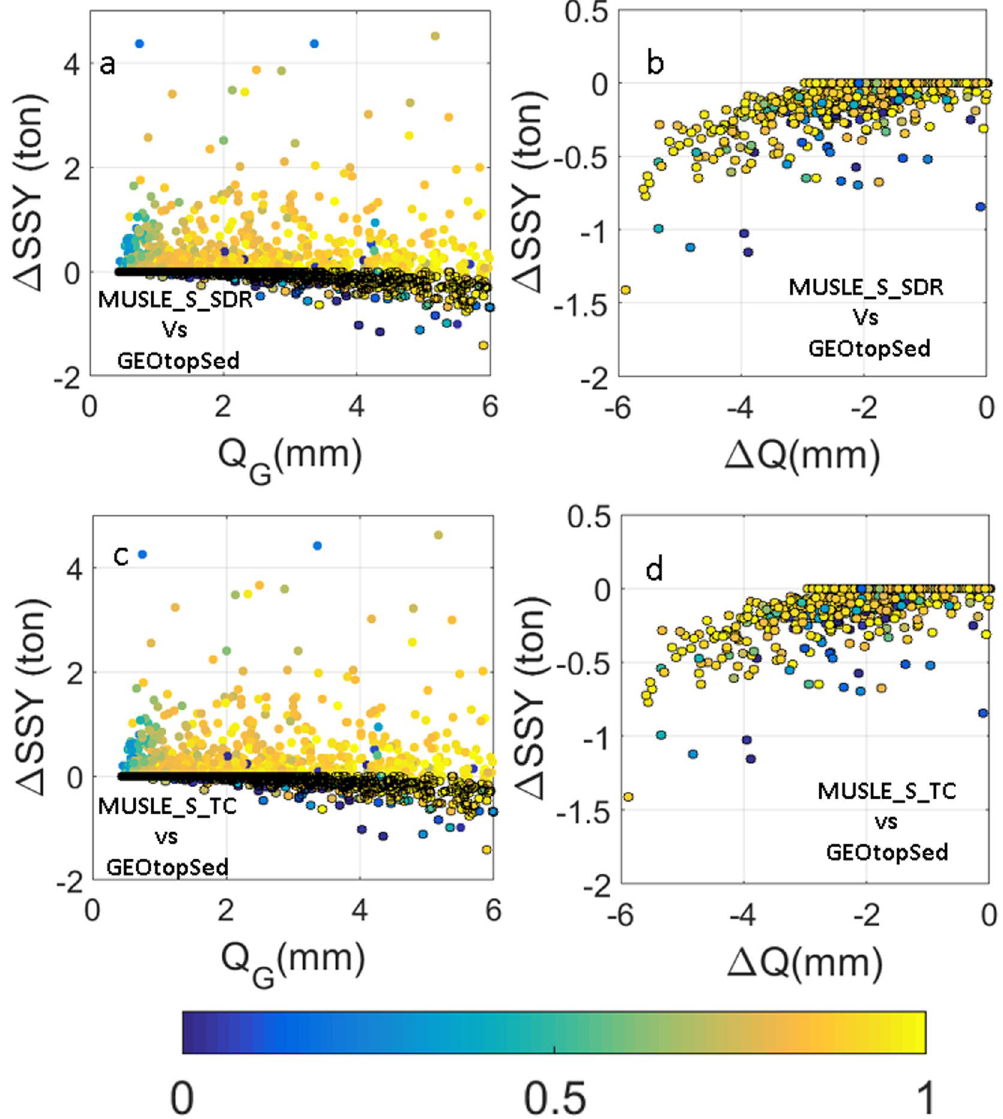
Figure 4. ( a , c ) Scatter plots of Δ SSY versus Q G for Q G < 6. ( b , d ) Scatter plots of Δ SSY versus Δ Q for Q G < 6 and Δ Q < 0. All plots were color coded with normalized watershed average antecedent soil moisture ( θ ˆ ) in the top 3.5 cm soil layer. Colored dots with black edges indicate underestimation of surface runoff by MUSLE based model configurations w.r.t.